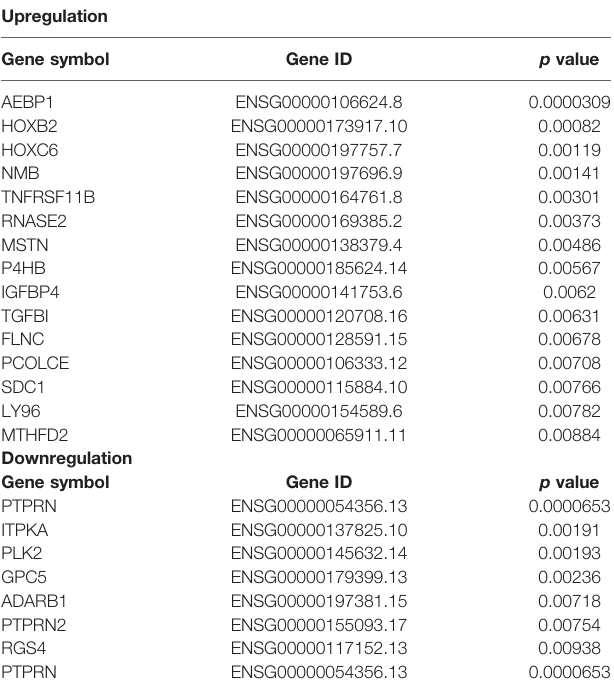
TABLE 1 | DEGs associated with overall survival in both the GSE4290 and GSE50161 datasets. Upregulation